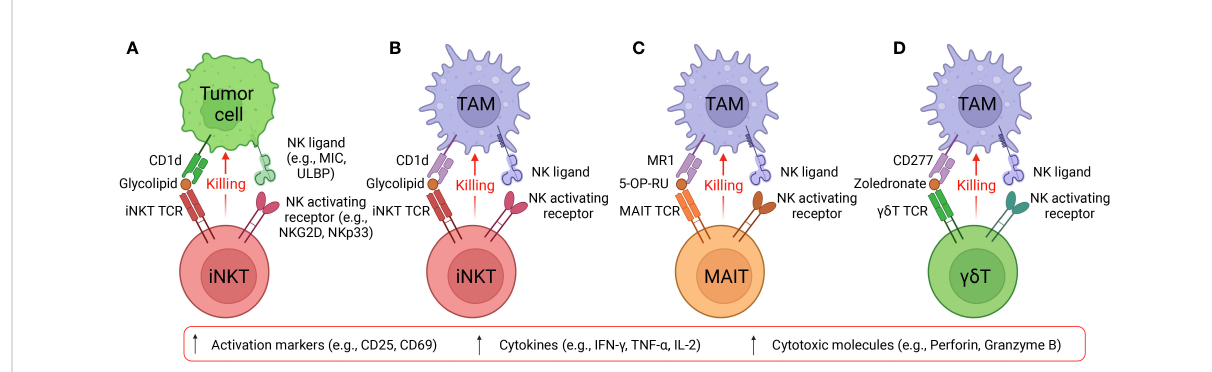
FIGURE 2 Targeting tumor and immunosuppressive cells by innate T cells. (A) Diagram showing iNKT cells target CD1d + tumor cells using NK/TCR double mechanisms. MIC, MHC class I chain-related protein. ULBP, UL16 binding protein. (B) Diagram showing iNKT cells target CD1d + TAMs using NK/ TCR double mechanisms. (C) Diagram showing MAIT cells target CD1d + TAMs using NK/TCR double mechanisms. MR1, major histocompatibility complex, class I-related protein. 5-OP-RU, 5-(2-oxopropylideneamino)-6-D-ribitylaminouracil. 5-OP-RU is a microbial ribo fl avin-derived antigen and can speci fi cally activate MAIT cells. (D) Diagram showing gd T cells target CD1d + TAMs using NK/TCR double mechanisms. Zoledronate is a nitrogen-containing bisphosphonate and can activate gd T